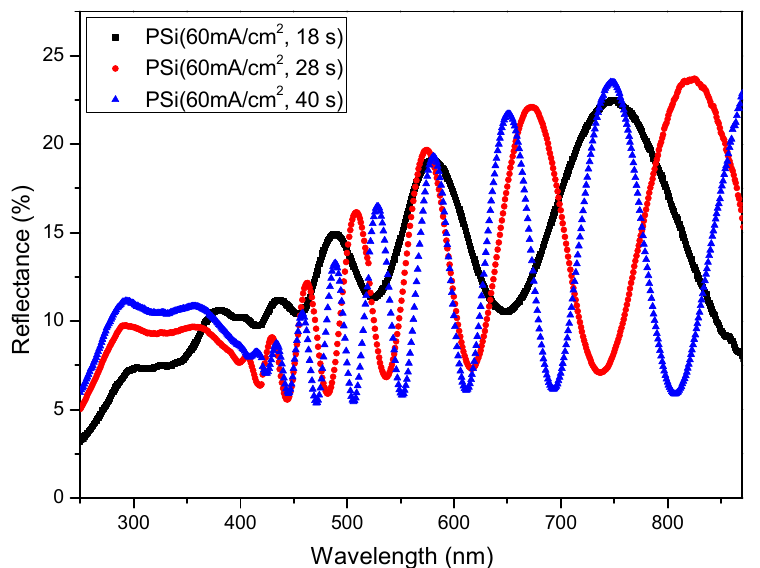
Figure 4. Overall reflectance of typical nanostructured PSi samples as a function of the thickness of PSi layer.